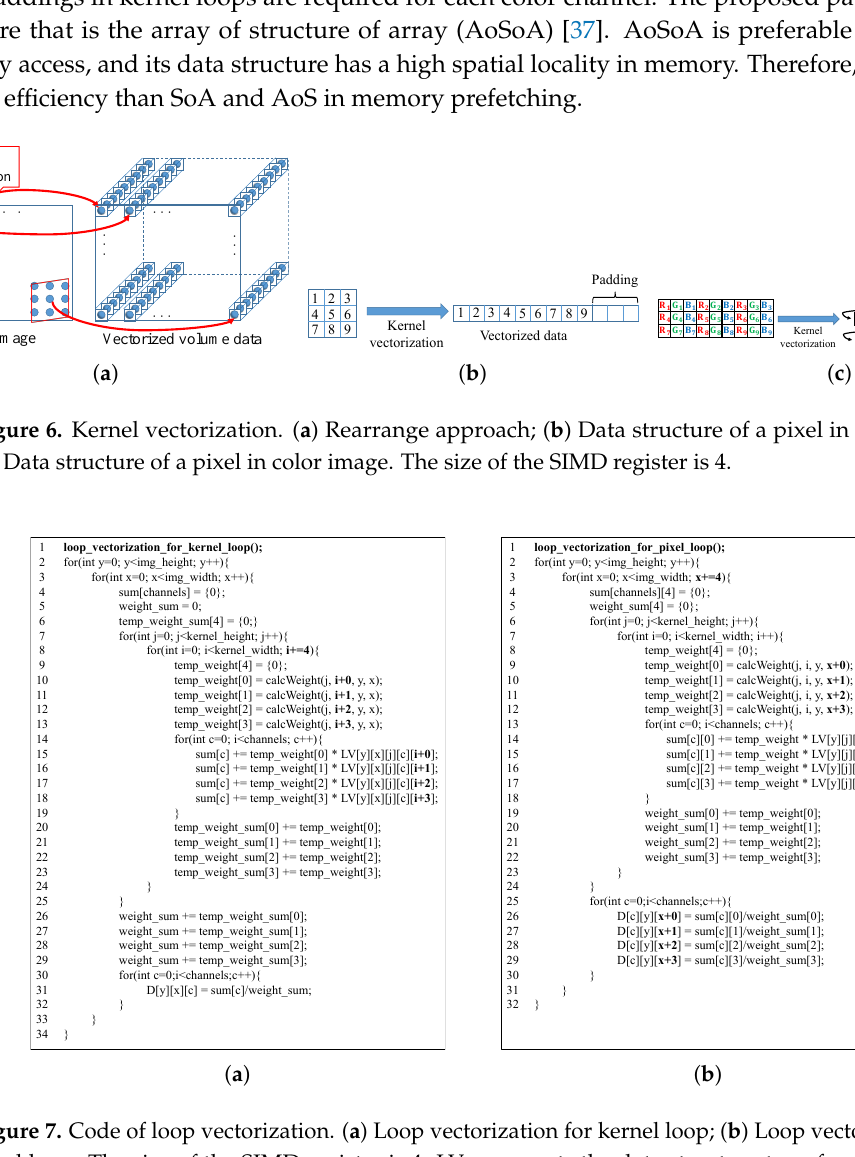
Figure 7. Code of loop vectorization. ( a ) Loop vectorization for kernel loop; ( b ) Loop vectorization for pixel loop. The size of the SIMD register is 4. LV represents the data structure transformed by loop vectorization. For the data structure, the data in the final operator [ · ] can be sequential access. The data structure is always accessed